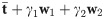
Variants of plausible FSTT distributions for the anonymized given skull.Top: Partial sphere model variants along the two principal components with the largest eigenvalues: We visualize t¯+γ1w1+γ2w2, where γi = ci ⋅ σi, i = 1, 2, is the weight containing the standard deviation σi to the corresponding eigenvector wi, and the factor ci ∈ {−2, 0, 2}. Bottom: Head model fitted to these partial sphere models.